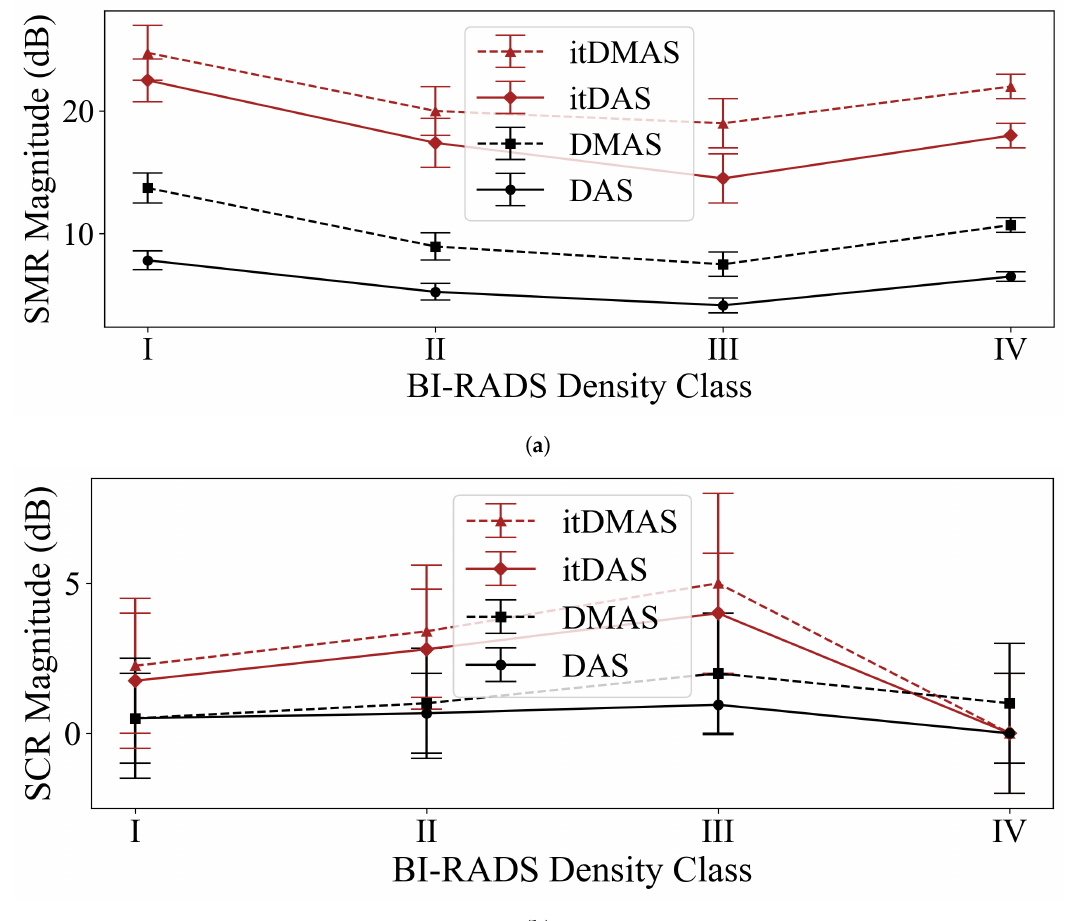
Figure 4. ( a ) Average SMR and ( b ) average SCR for the reconstruction algorithms using scans of phantoms representative of the four BI-RADS density classification